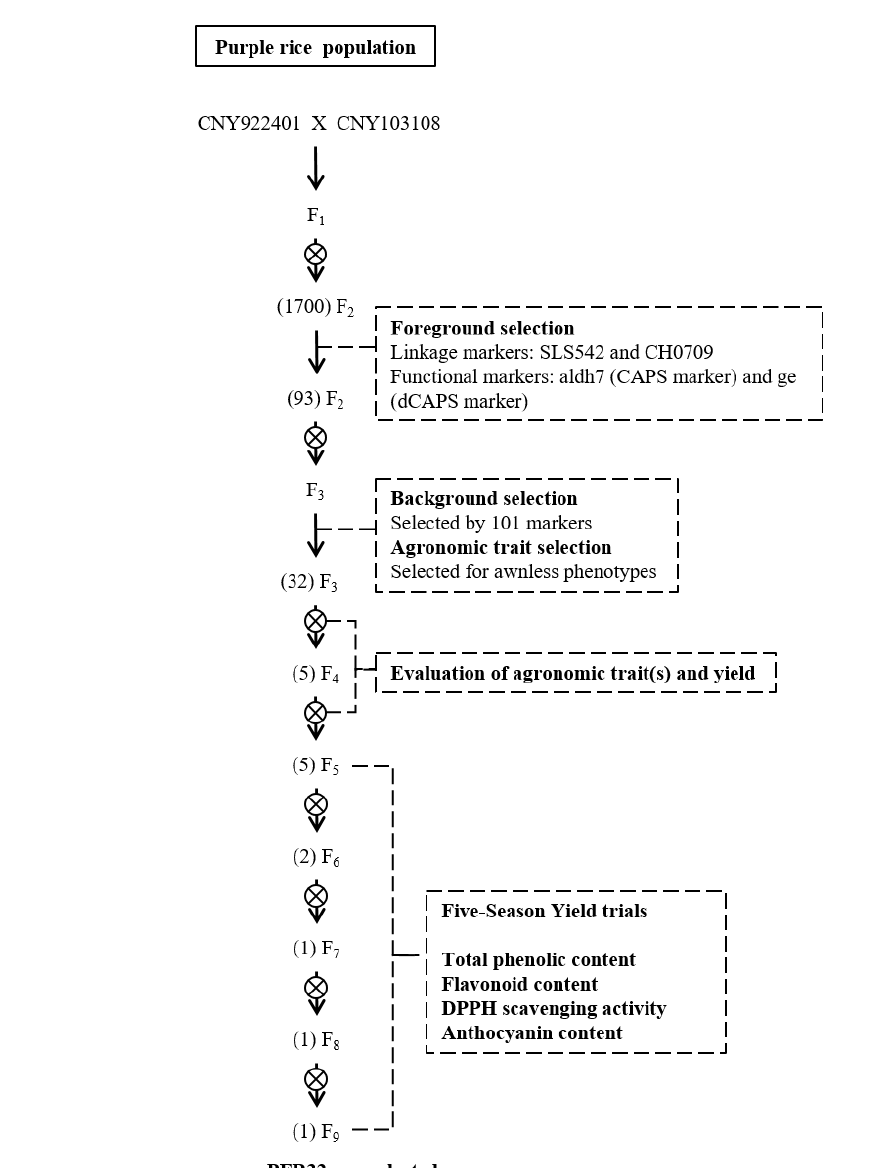
Figure 2. The breeding scheme for the purple functional rice population (PFR). Molecular markers were used for both foreground and background selections. Yield trials and antioxidant activity evaluations were performed. The numbers of the selected lines are enclosed in parentheses.